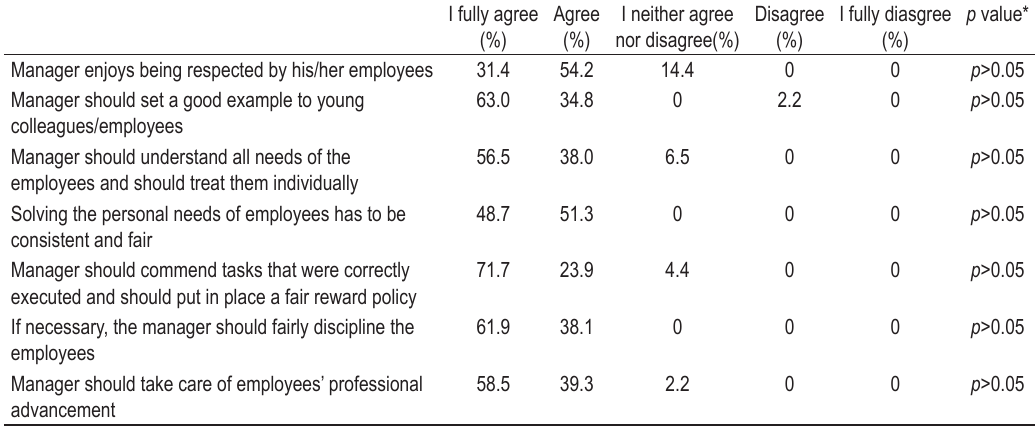
TABLE 4. Assessment of the leadership skills between the managers of different length of managerial experience